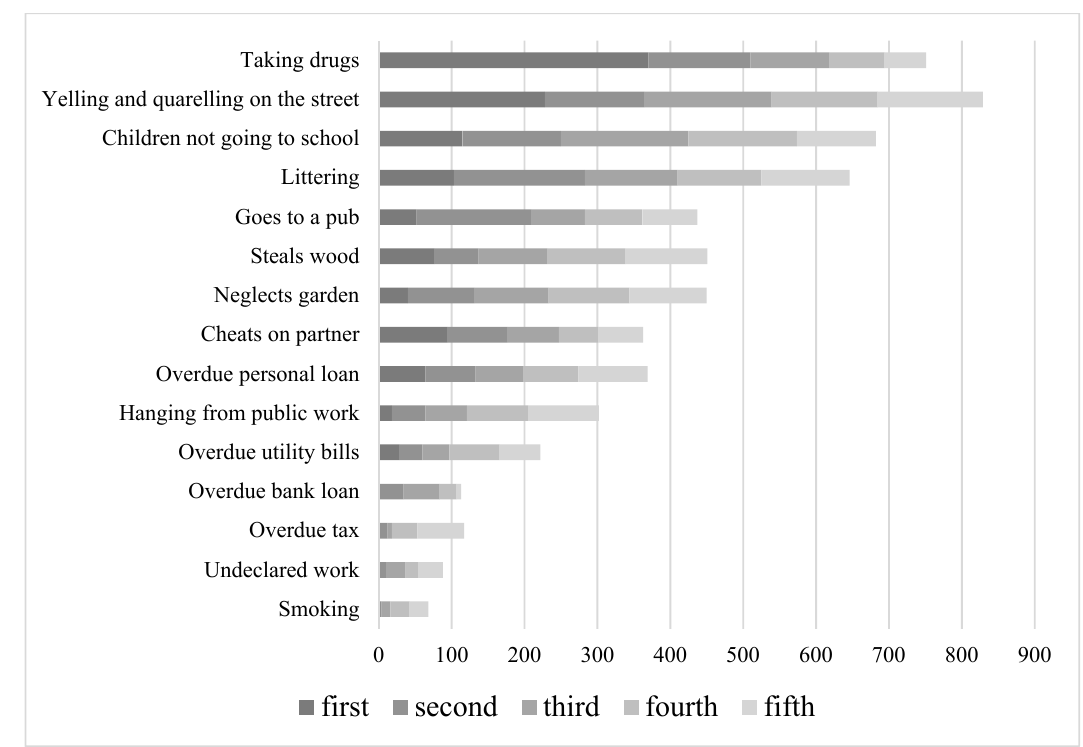
Figure 4. Perceived social aversion (number of mentions among the first five most convicted behaviors). Source: Questionnaire-based survey, small settlements of BAZ County, Hungary, 2019. Note: The first five most convicted behaviors were ranked by the respondents (first: the most convicted behavior; second: the second most convicted behavior, etc.).